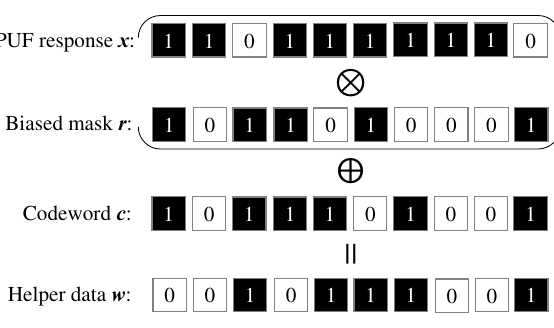
Figure 5: Example of BM-based